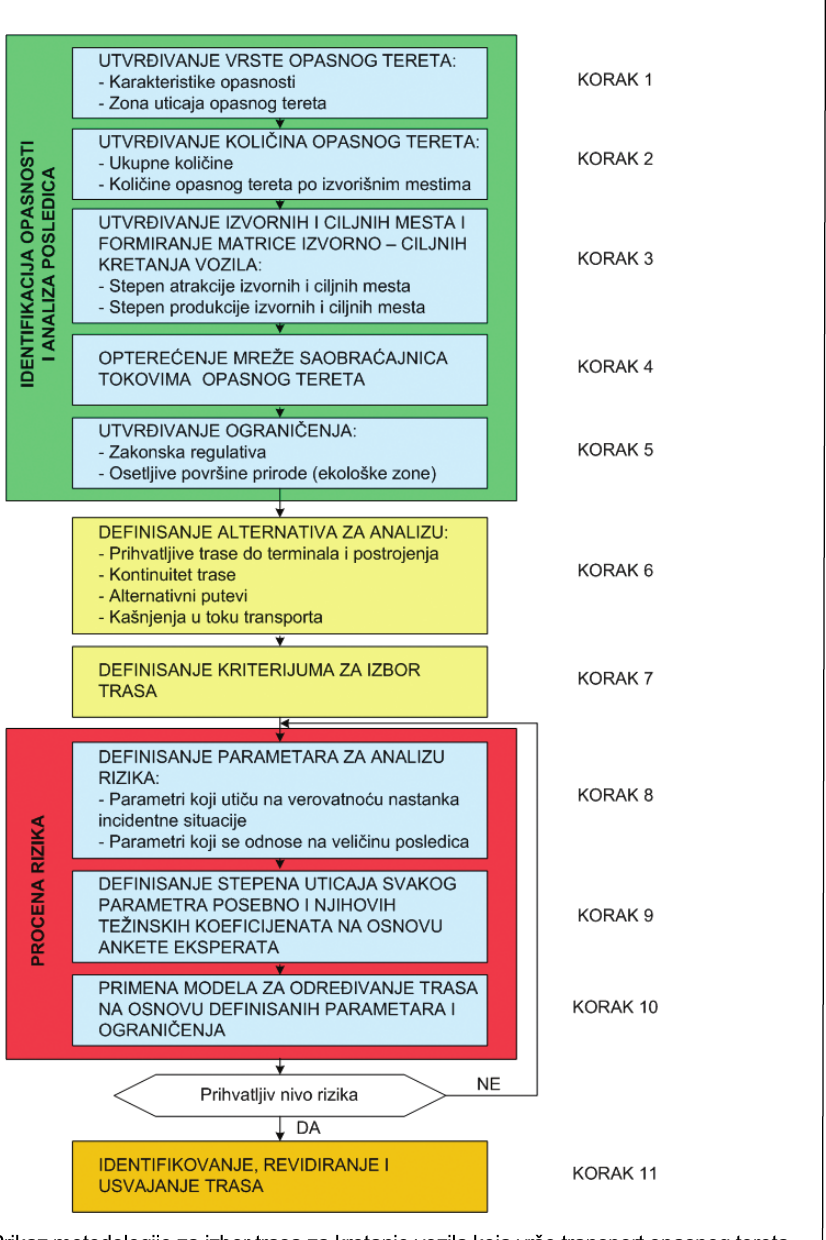
Figure 1 – Methodologies for the selection of routes for the movement of vehicles